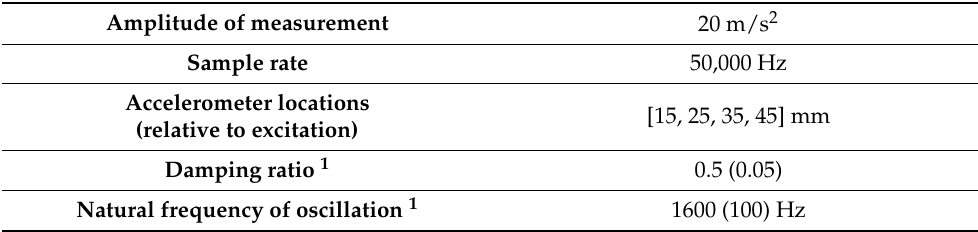
Table 1. Parameters used to define the simulated shear wave tensiometer